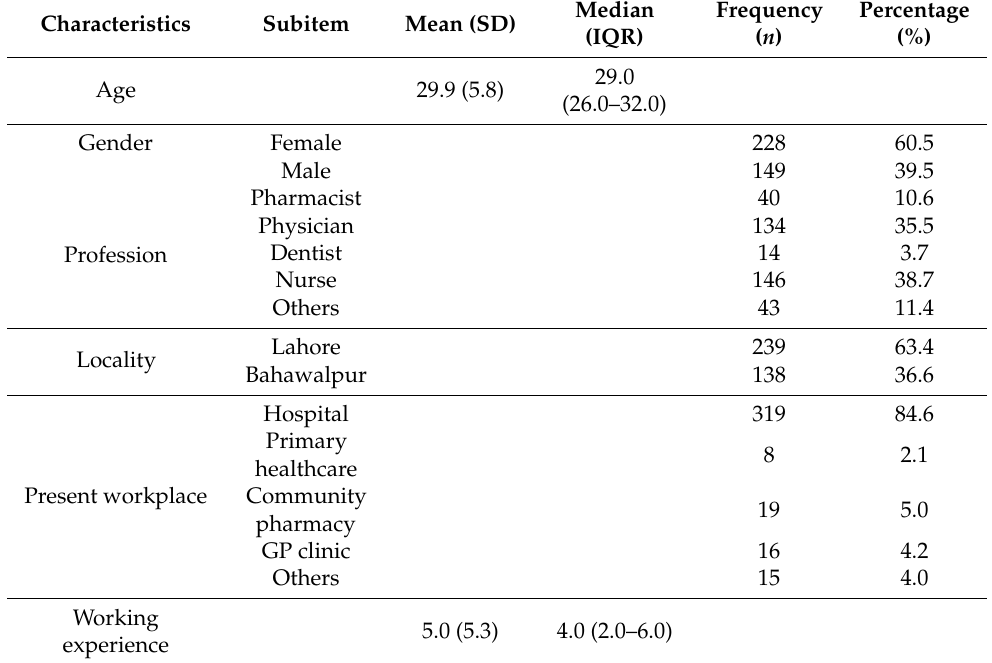
Table 1. Demographic profiles of the healthcare